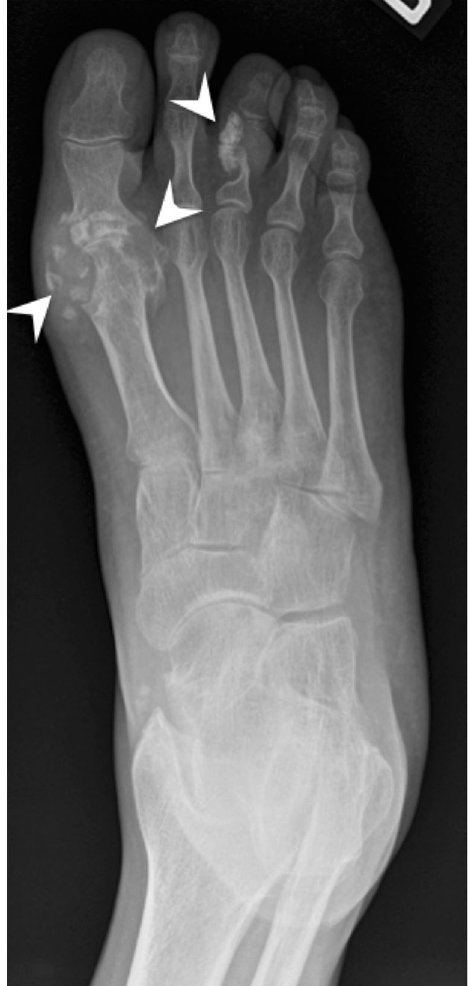
Fig. 16 Gout. Frontal radiograph of the right foot shows tophi and erosions. Some tophi may present with mineralisation